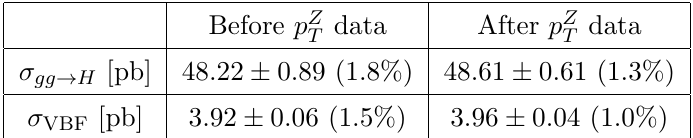
Table 11 . Predictions for the Higgs cross sections in 13 TeV pp collisions before and after inclusion of the p Z data in the global (cid:12)ts. The indicated errors are the PDF errors computed according to T the NNPDF